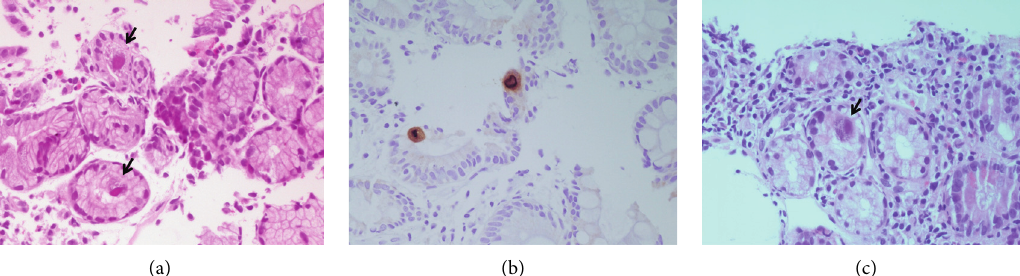
Figure 3: The patient’s histological findings. (a) H&E staining showing chronic gastritis and scattered large cells with intranuclear and intracytoplasmatic inclusion bodies (arrows); (b) positive IHC in a representative duodenal specimen; (c) H&E staining showing duodenitis and large cells with inclusion bodies (arrow).